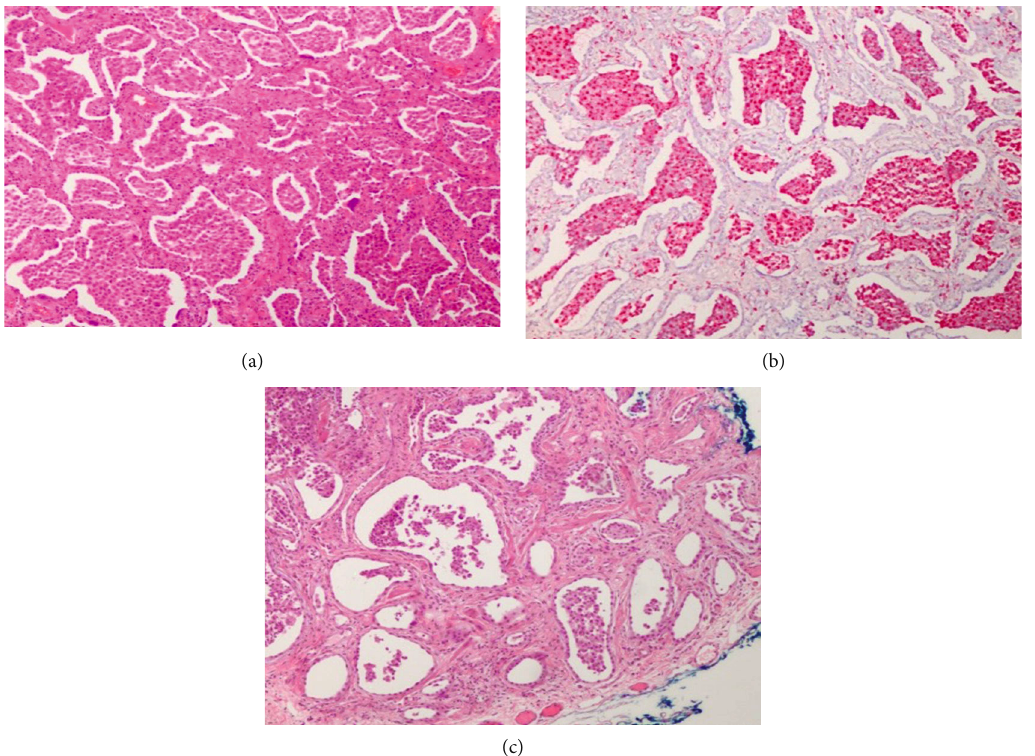
Figure 5: (a) Histopathology showing di ff use, uniform macrophage accumulation within alveolar spaces. (b) Histopathology highlighted on immunochemistry for CD68. (c) Histopathology demonstrating focal interstitial thickening and in fl ammatory